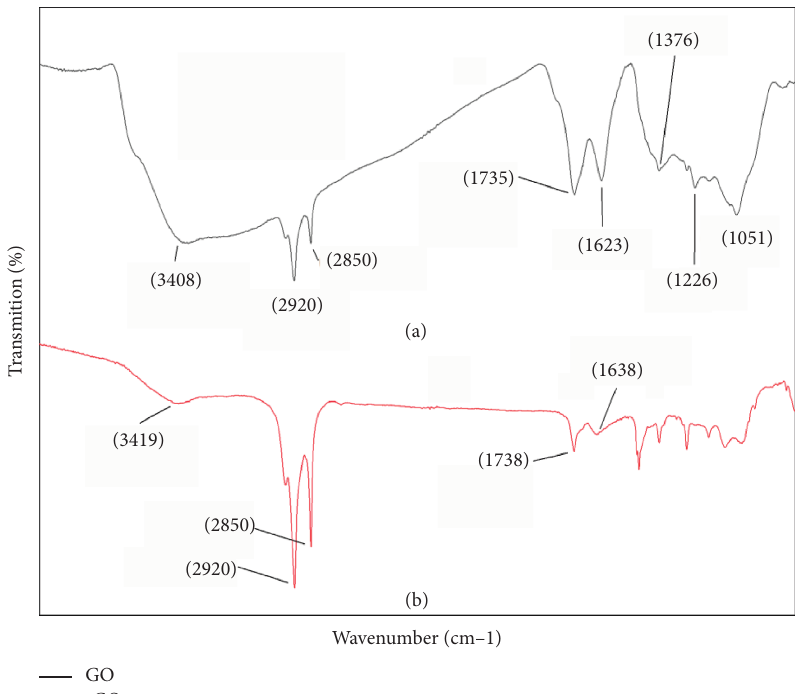
Figure 5: FTIR spectra of graphene oxide (a) and reduced graphene oxide (b).